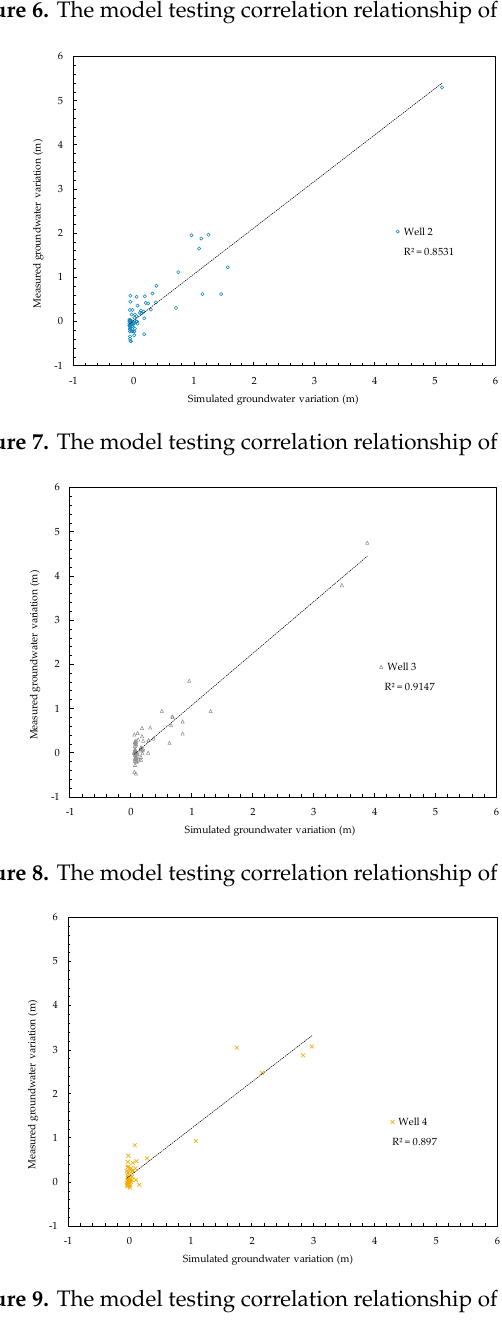
Figure 9. The model testing correlation relationship of Well 4.